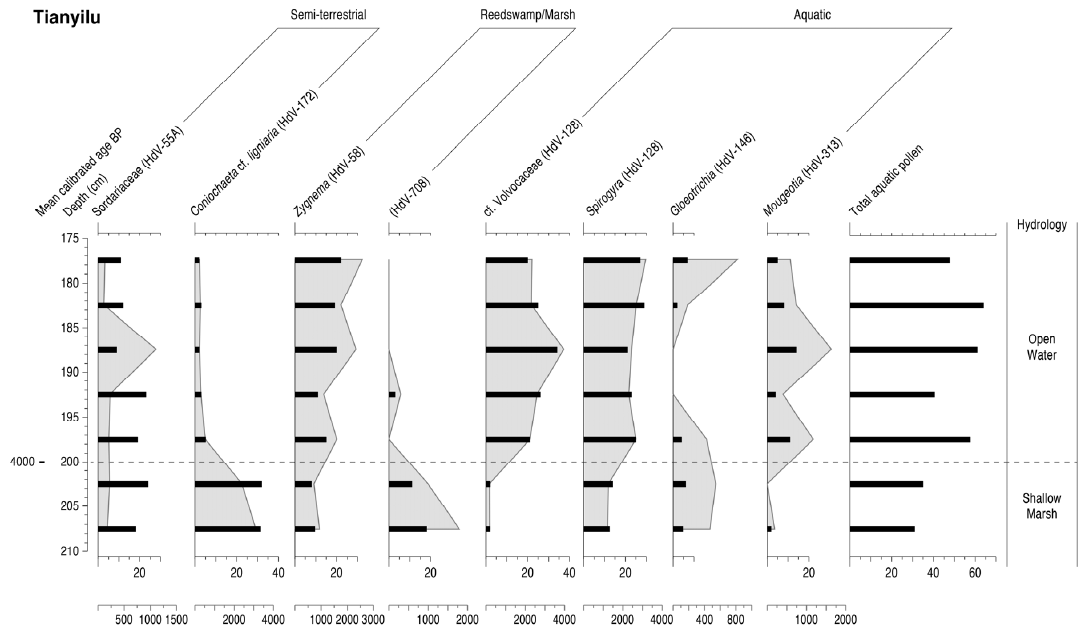
Figure 3. Frequencies of selected NPP taxa (histogram bars calculated as % total NPPs) from Tianyilu. A combined aquatic pollen curve is also shown, calculated as percentages of total land pollen. Pollen concentration values for the NPPs are shown as shaded curves (numbers of grains per cc. on the secondary x-axis).